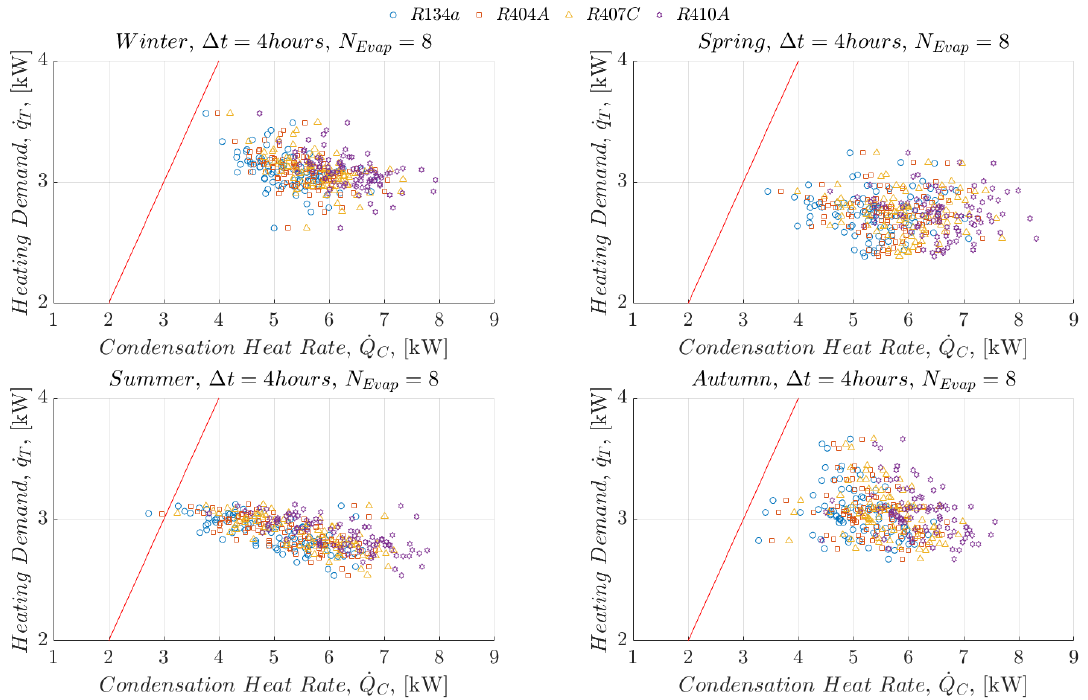
Figure 8. Thermal capacity seasonal density rate for all refrigerants and eight collectors during 4 h.